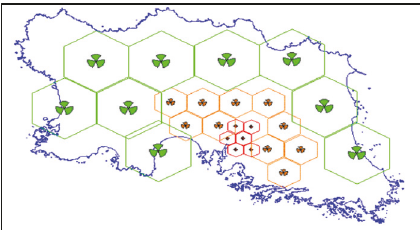
Figure 1: Example of cellular network